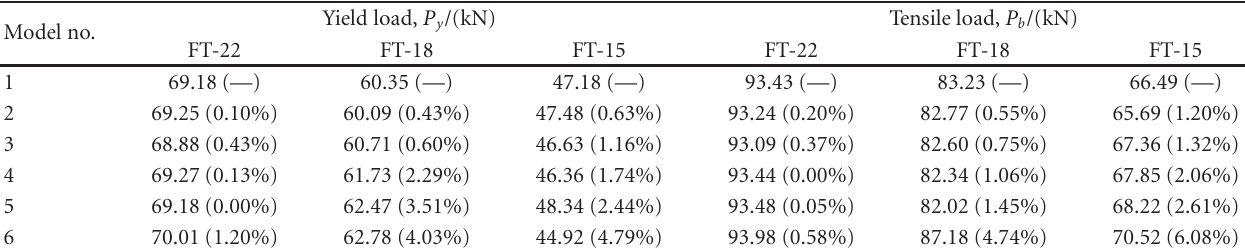
Table 2: Yield and tensile strength predictions of di ff erent RCSM analytical models.